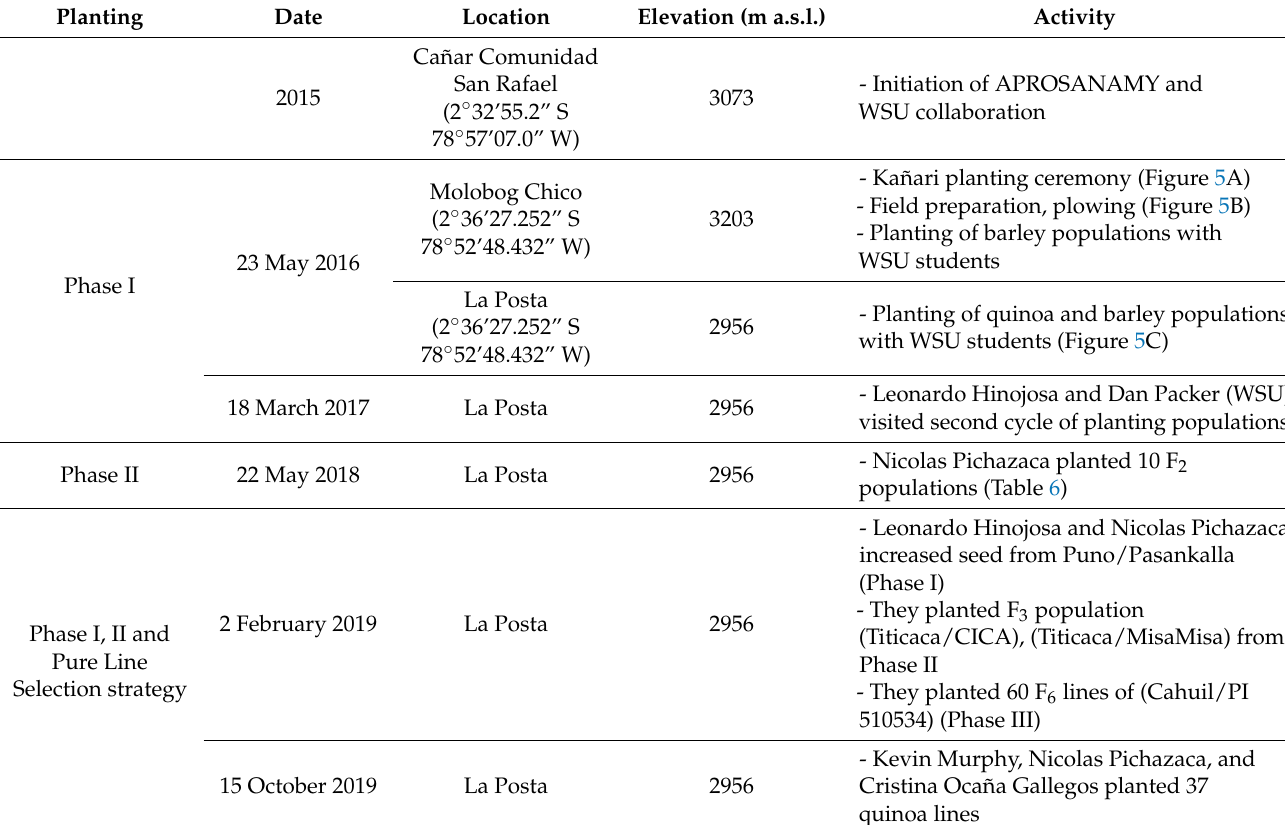
Table 7. Timeline of APROSANAMY and WSU collaboration, including dates, locations, and activities.